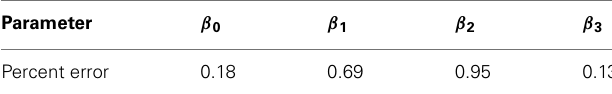
TableA1 | Estimated percent errors of the curve-fitting algorithm for 1000 simulated